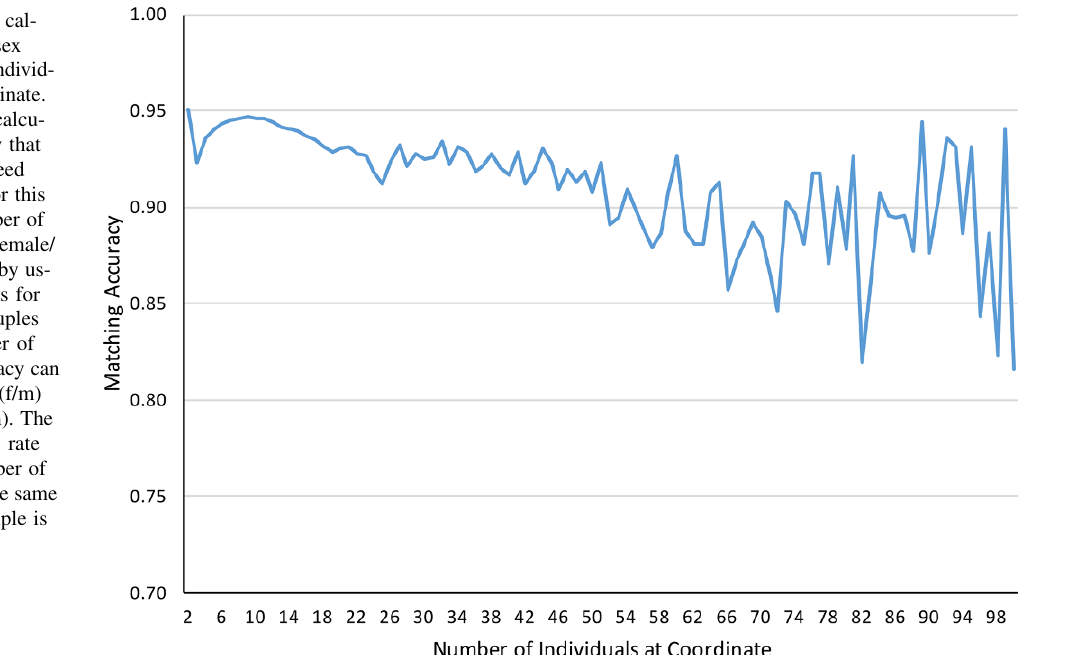
Fig. 4 Match Accuracy cal- culated based on Same-sex Matches by Number of Individ- uals living at same coordinate. (Note: In this figure we calcu- late the likely probability that a matched couple is indeed married to each other. For this we assume that the number of matched male/male and female/ female couples obtained by us- ing the same algorithm as for matched male/female couples is a proxy for the number of false matched. The accuracy can figure plots this accuracy rate as a function of the number of individuals who live at the same coordinate where the couple is